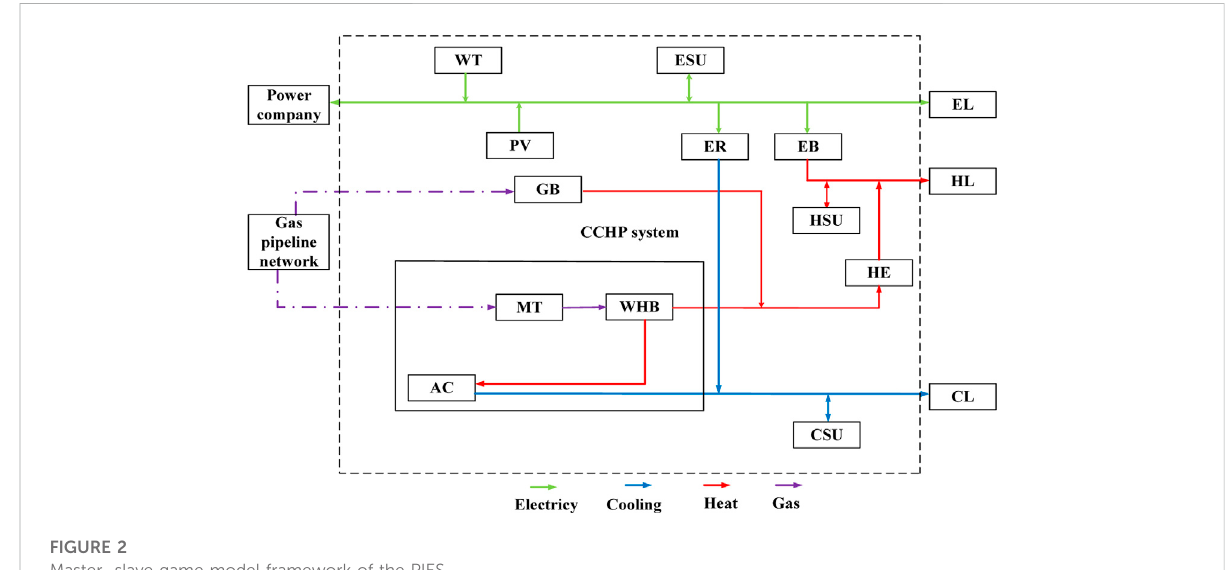
FIGURE 2 Master – slave game model framework of the PIES.